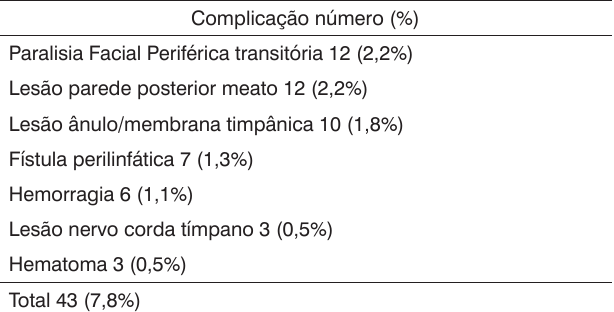
Tabela 2. Complicações Menores. Complicação número (%) Paralisia Facial Periférica transitória 12 (2,2%) Lesão parede posterior meato 12 (2,2%) Lesão ânulo/membrana timpânica 10 (1,8%) Fístula perilinfática 7 (1,3%) Hemorragia 6 (1,1%) Lesão nervo corda tímpano 3 (0,5%) Hematoma 3